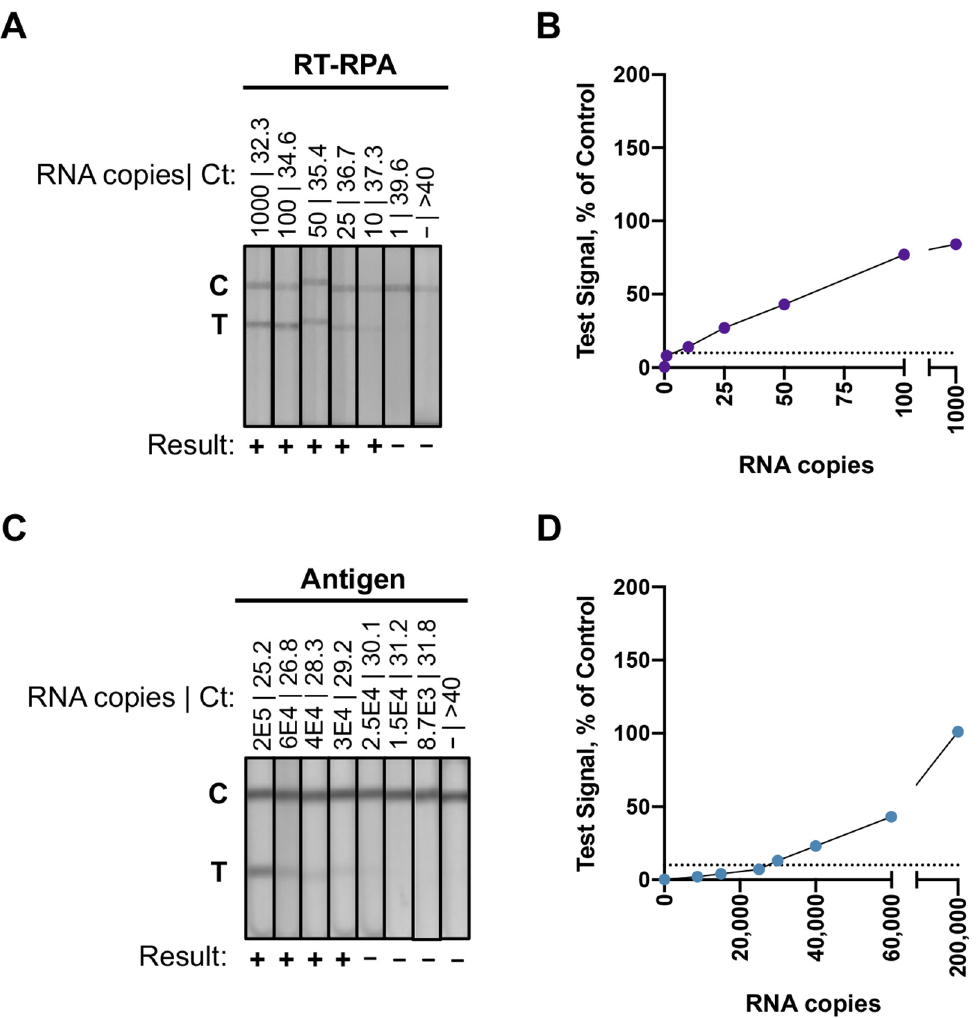
Figure 2. Analytical sensitivity of the RT-RPA assay and the antigen test using nasal swab dilution specimens. ( A ) Lateral flow strips for the RT-RPA reactions with dilution specimens containing RNA copies ranging from 0 to 1000. ( B ) Plot from the RT-RPA assay results quantified by the mobile phone application. The x-axis corresponds to dilutions’ specimens with known input copies of SARS-CoV-2 RNA. The y-axis corresponds to background subtracted test signal normalized to the control line for each lateral flow strip. Test results (purple dots) less than 10% of control are considered negative results, which is indicated by the black dashed line. ( C ) Lateral flow strips for the antigen tests with dilution specimens containing RNA copies ranging from 0 to 200,000. ( D ) Plot from the antigen tests results quantified by the mobile phone application. The x-axis corresponds to dilutions’ specimens with known input copies of SARS-CoV-2 RNA. The y-axis corresponds to background subtracted test signal normalized to the control line for each lateral flow strip. Test results (blue dots) less than 10% of control are considered negative results, which is indicated by the black dashed line.